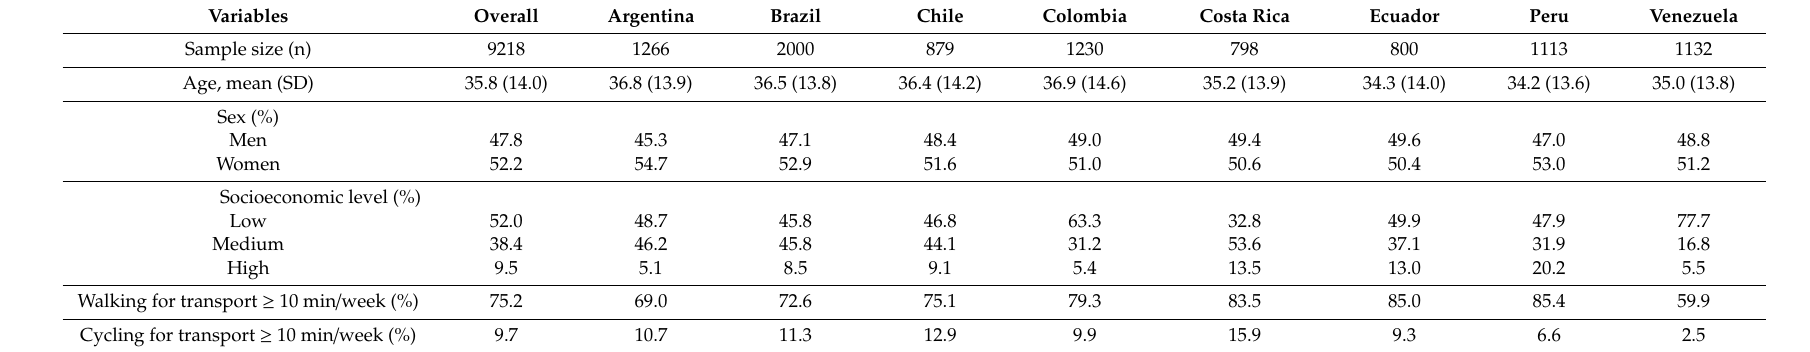
Table 2. Demographic characteristics and walking and cycling for